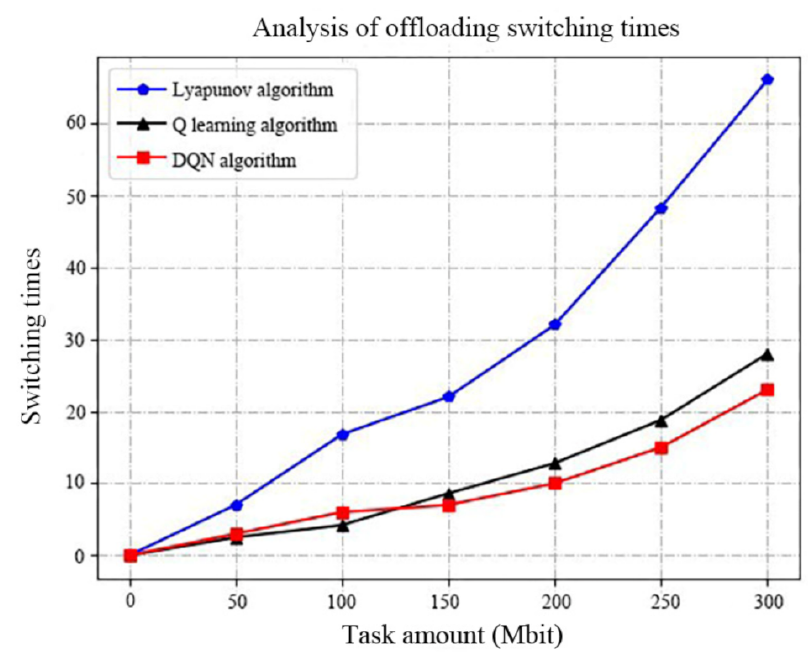
Figure 7. The change in the number of subtasks switching frequency changes in offloading. Blue indicates the computation offloading based on Lyapunov algorithm, black indicates the computation offloading based on classical Q-learning algorithm, and red indicates the computation offloading method of DQN algorithm proposed in this paper. Compare the number of network switching with task amount during task offloading of the three